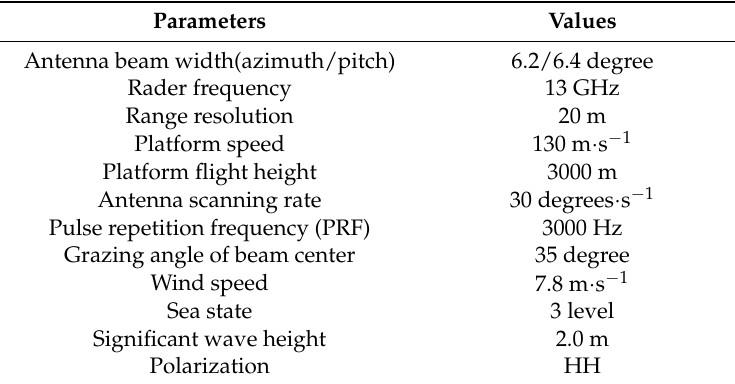
Table 1. Key parameters of the circular scanning SAR and sea surface.